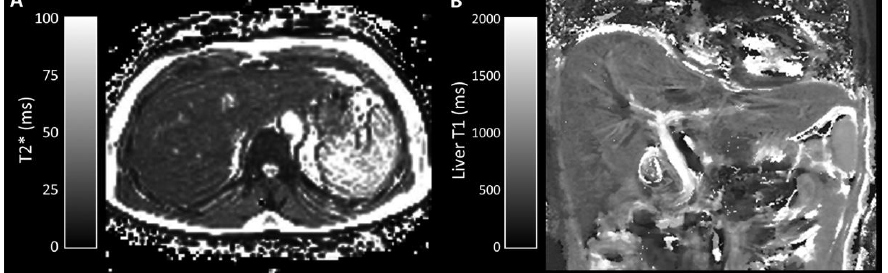
Figure 3. Axial MRI Proton Density Fat Fraction map examples from ( A ) non-IFALD and ( B ) IFALD steatosis patients. Average liver fat fraction was ( A ) 1.4% for the non-IFALD patient as represented by the darker liver parenchyma and ( B ) 27.4% for the IFALD steatosis patient as represented by the brighter liver parenchyma. Note the striking disparity in subcutaneous adiposity between patients. Figure 4. Parametric mapping of ( A ) liver T2* (axial) and ( B ) liver T1 (coronal). Segmental regions of interest placed ( A ) on T2* maps were converted into liver iron concentration (average 13.6 μmol/g in this example) and ( B ) on T1 maps (average 848 ms in this example).